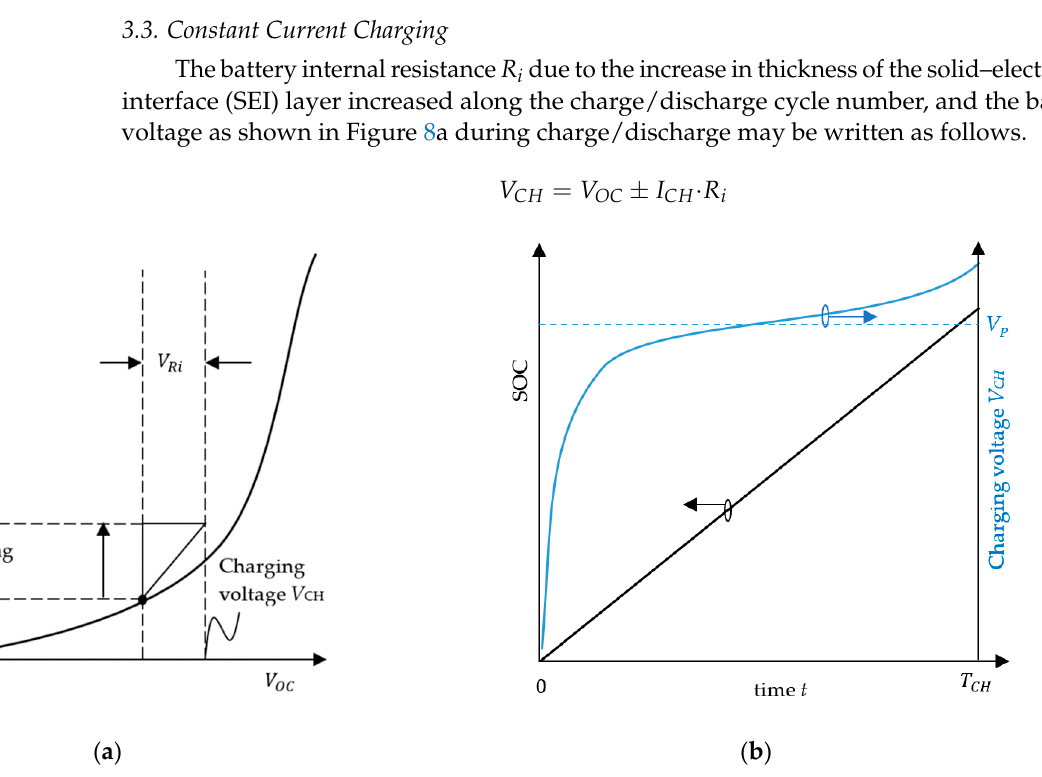
Figure 8. Constant current charging ( a ) SOC to voltage and ( b ) charging function.